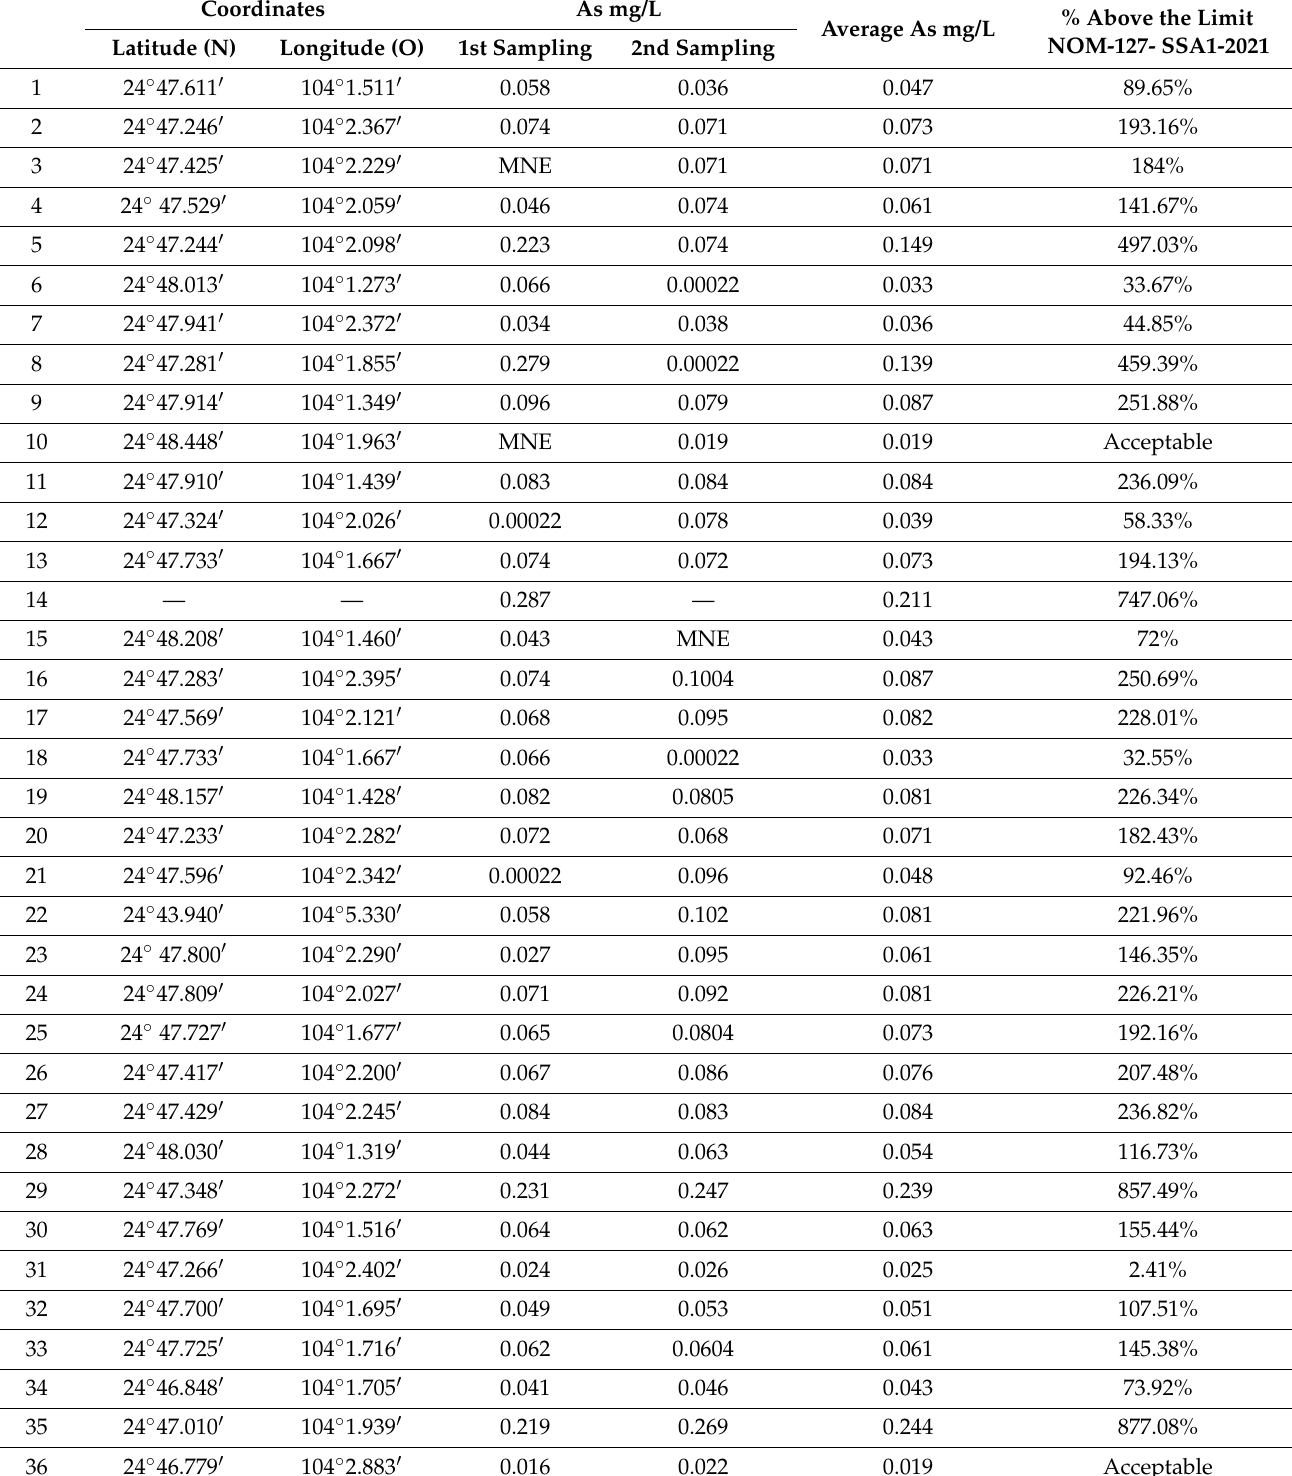
Table 2. Data obtained from the sampled water intakes, showing the coordinates, the average concentration of the first and second sampling, the average, and whether it exceeds the values according to NOM-127-SSA1-2021 in Peñ ó n Blanco, Durango,